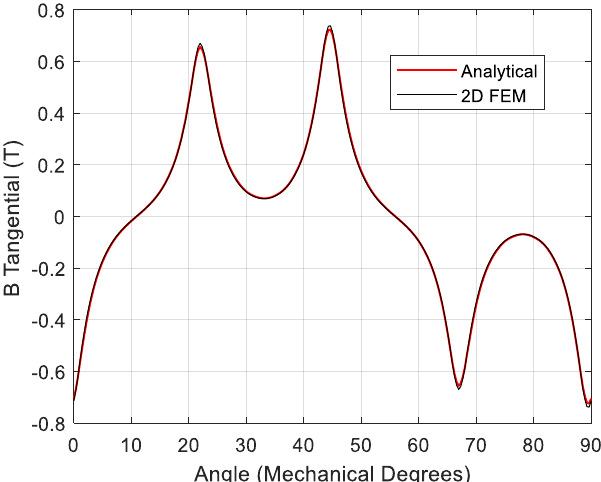
Figure 7. Tangential component of the flux density distribution at the maximum torque point: 2D